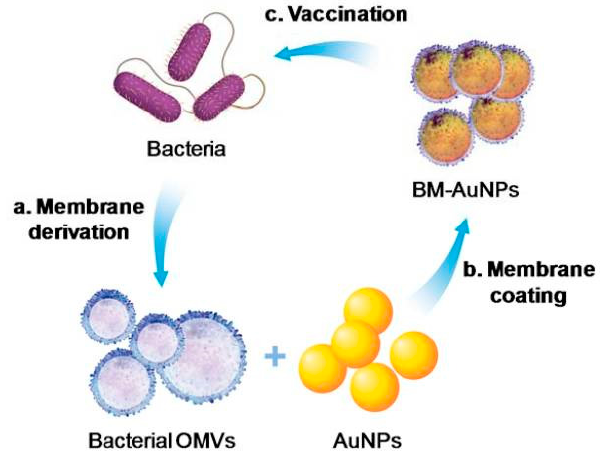
Figure 5. Schematic of antibacterial modulation via bacterial membrane-coated nanoparticles (NPs). Reproduced with permission from Ref. [61], Copyright © 2015, American Chemical Society.